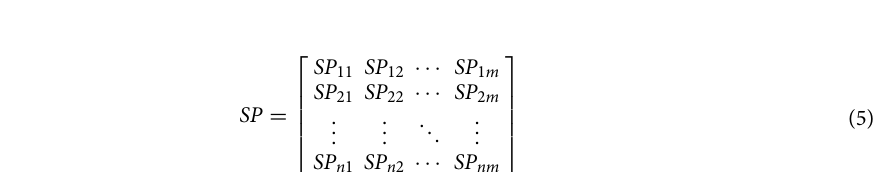
Figure 5. Structural slab quadratic